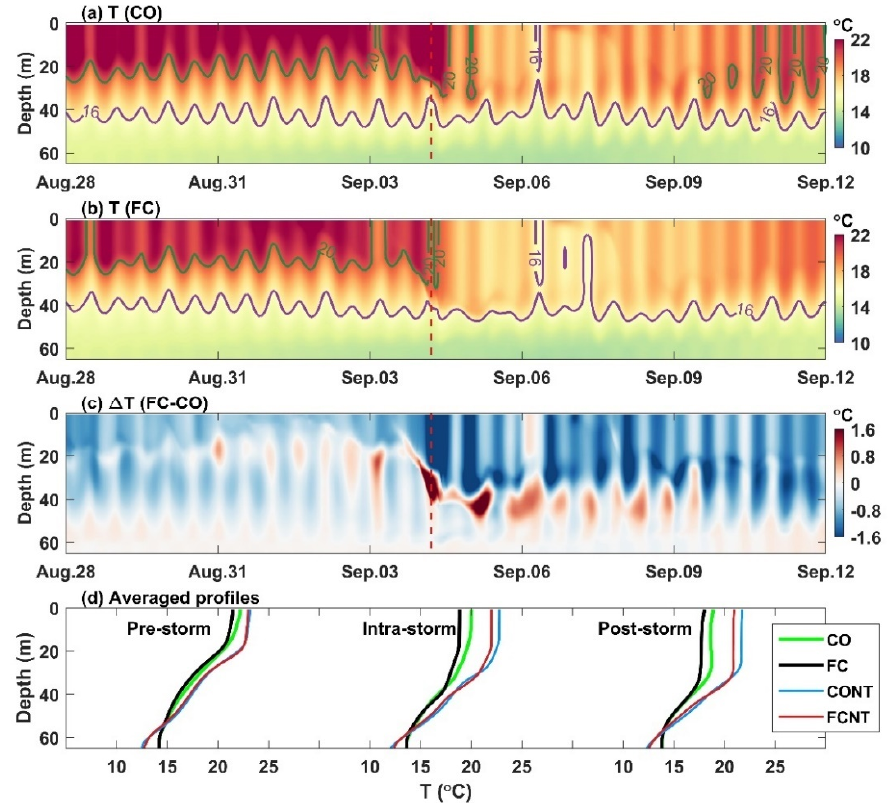
Figure 13. Time-depth distributions of temperature at buoy 44008 in runs ( a ) CO and ( b ) FC and differences ( c ) between runs FC and CO. Thick lines in ( a , b ) show contours of temperature. ( d ) Time- averaged temperature profiles in different model runs during the pre-storm, intra-storm, and post- storm periods.